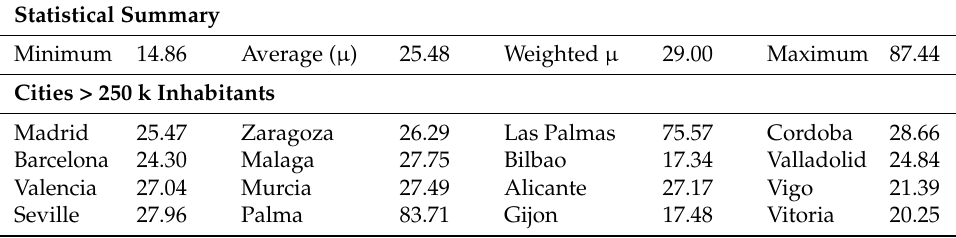
Figure A8. PV NPE in tons CO 2 eq (S1 (consumption saving scenario) and S2 (surplus sale scenario)).